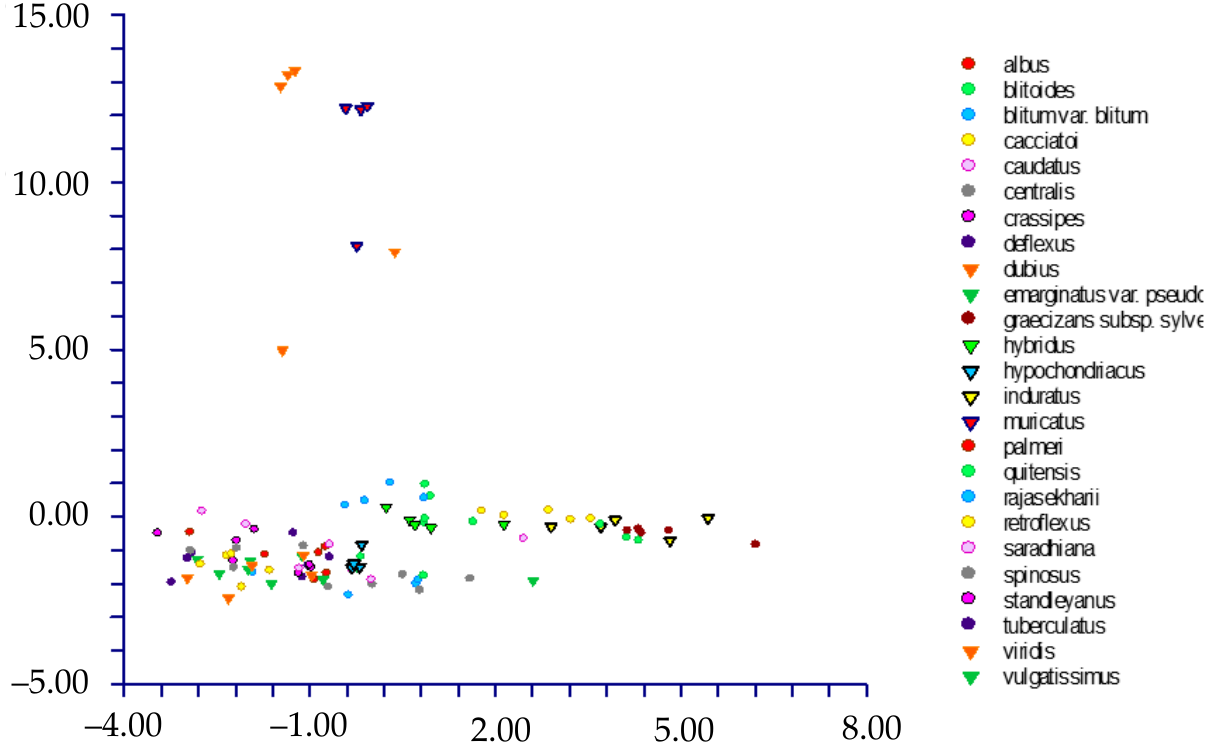
Figure 5. DA graph [first (axis- x ) vs. second (axis- y ) component] performed on samples classified using the taxa (species and below ranks) names.